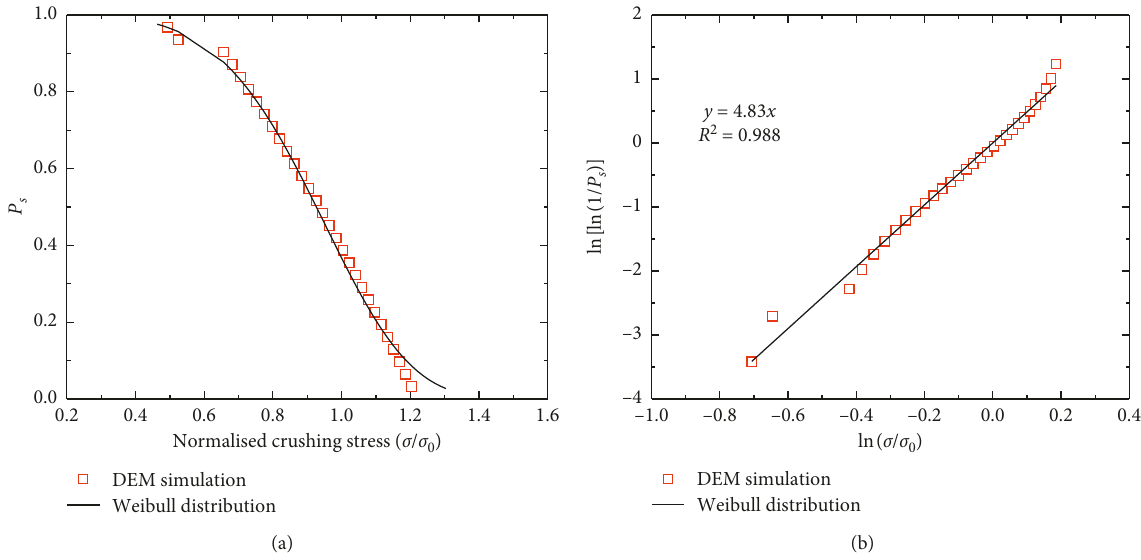
Figure 5: Survival distribution curve of single agglomerate crushing: (a) normalized distribution; (b) Weibull